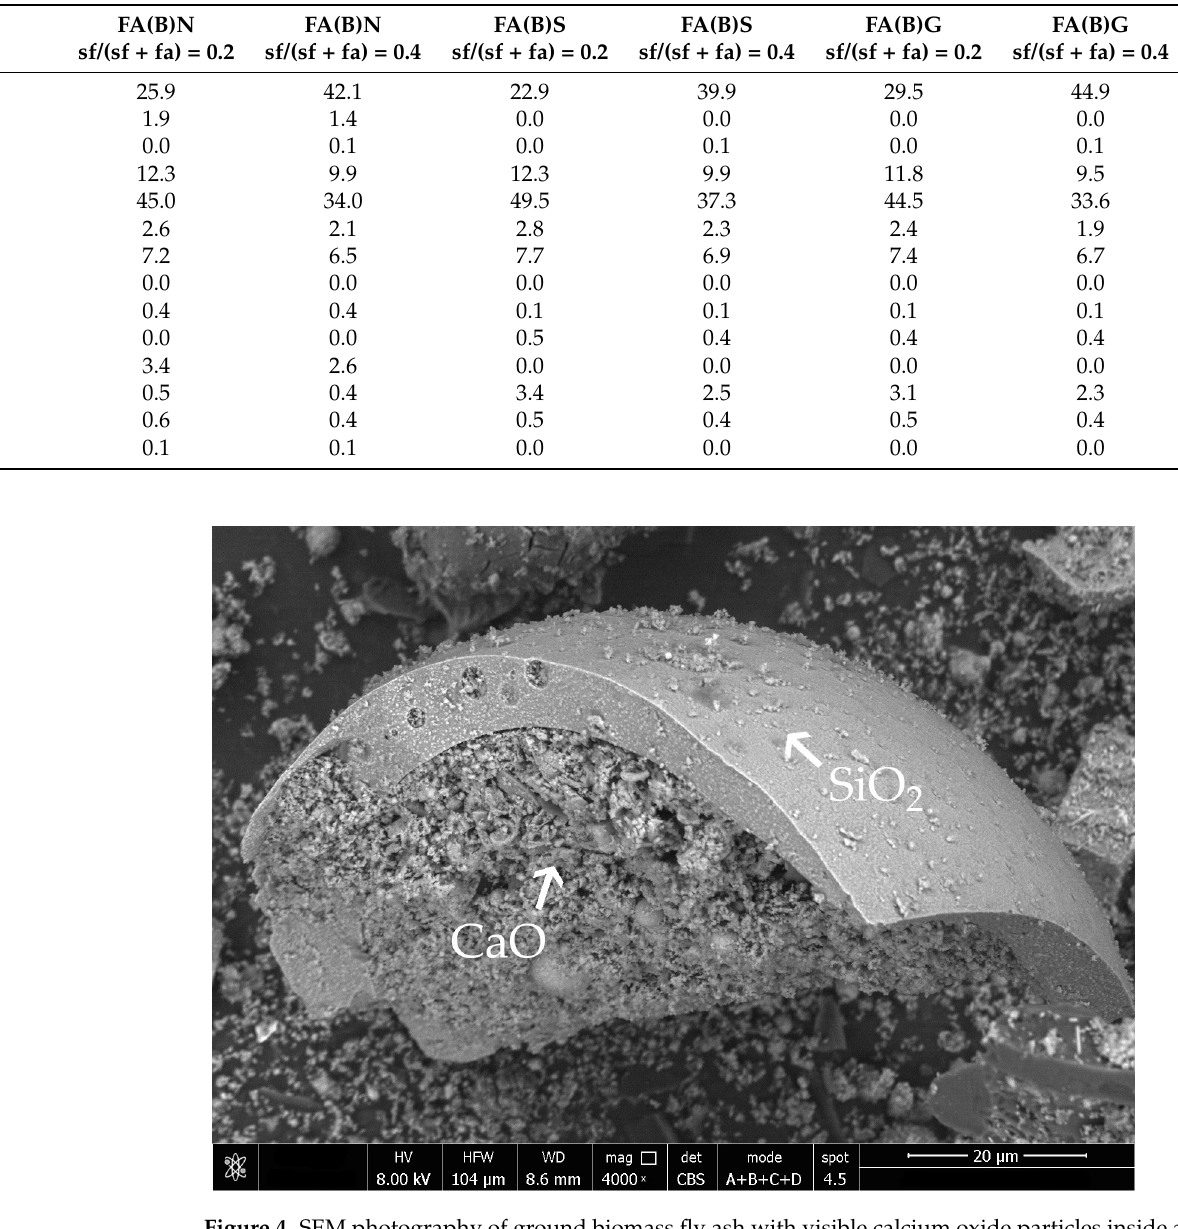
Table 9. Chemical Oxide Composition of Biomass Fly Ash Activated by Silica Fume Addition.